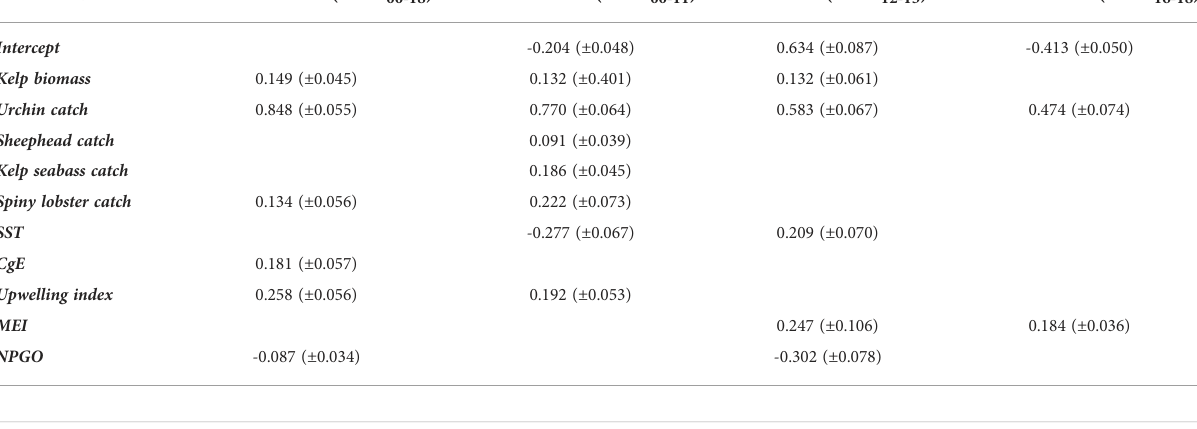
TABLE 2 Signi fi cant variables in time-speci fi c GLM, coef fi cients (± errors). Only signi fi cant variables ’ coef fi cients and intercepts are shown. Variable /Model